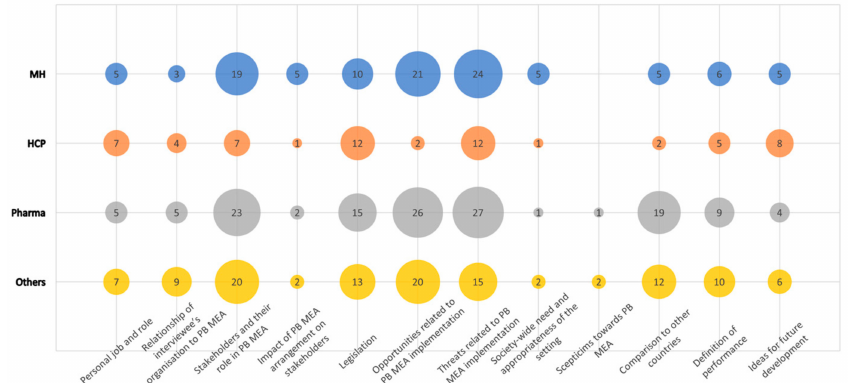
Figure 1. Frequency chart of codes in the top-level categories by occupational